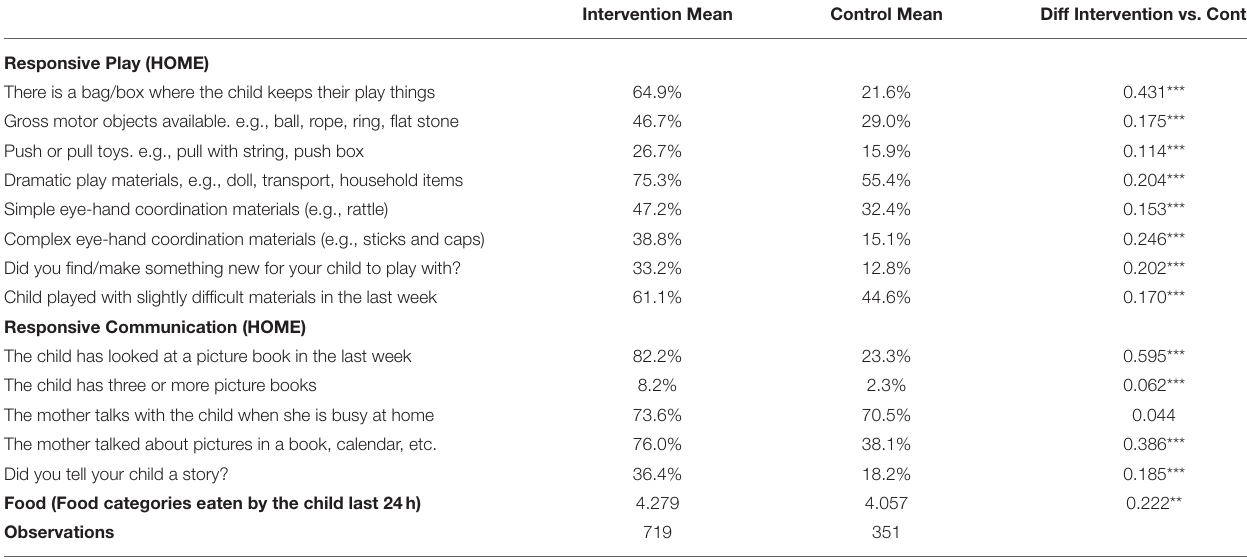
TABLE 6 | Maternal enactment of new practices.